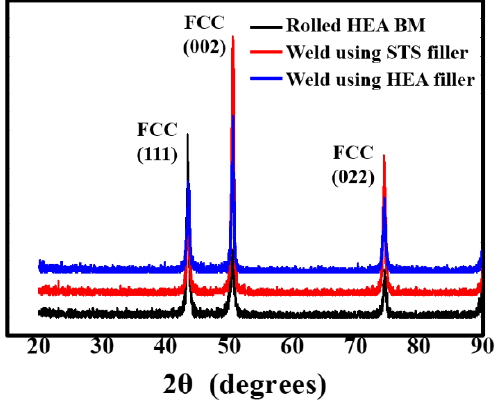
Figure 4. XRD patterns of rolled HEA base metal (BM) and GTA welds using HEA and STS 308L fillers.